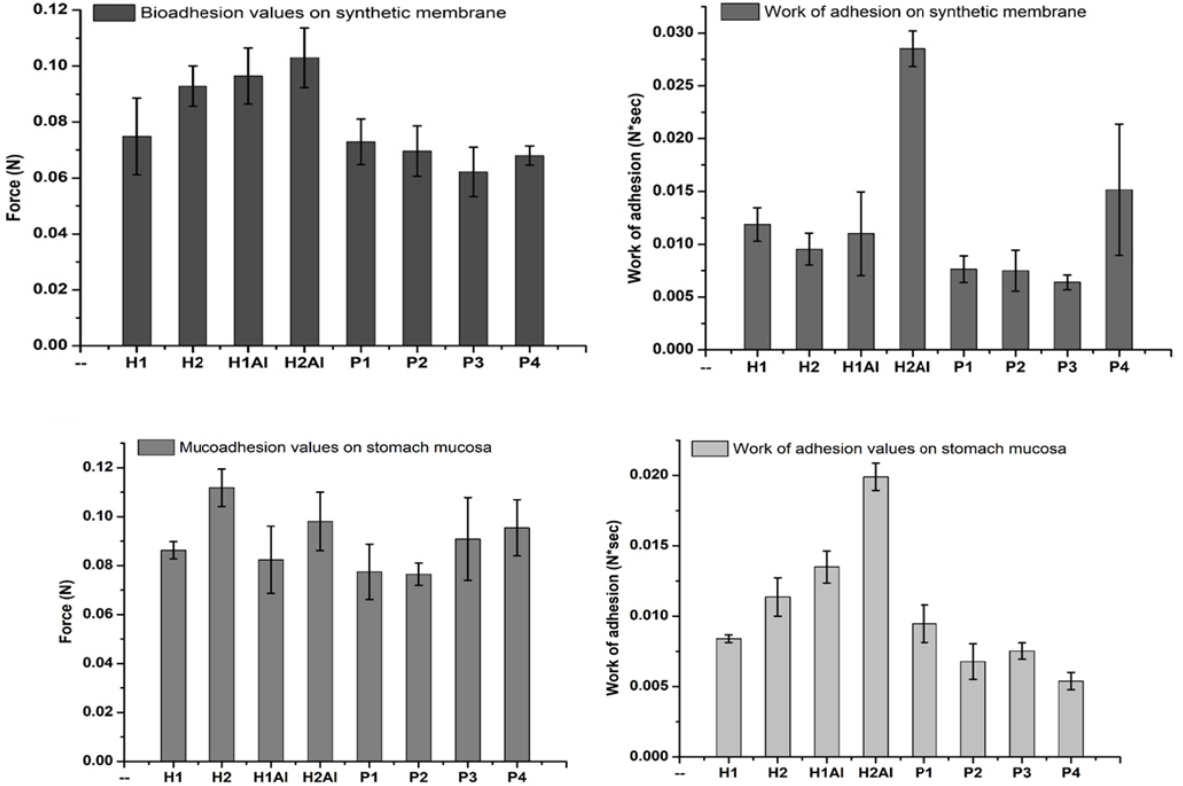
Figure 13. Bioadhesionand mucoadhesiontests for studied formulations.